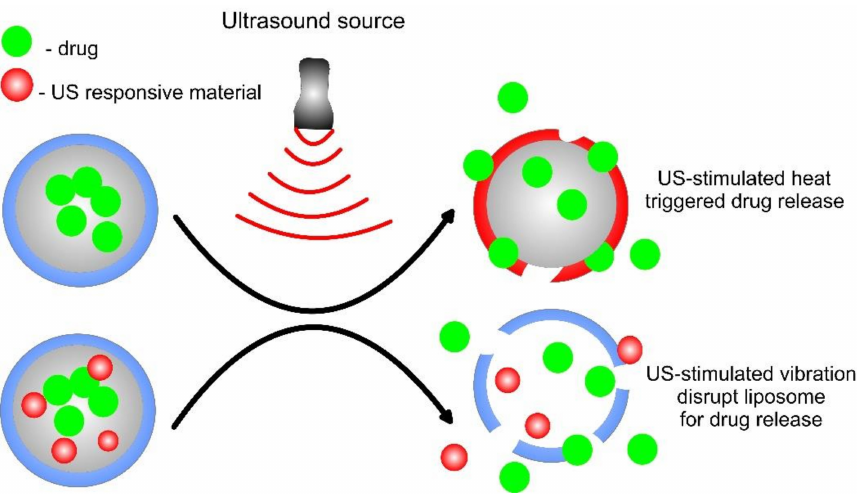
Figure 10. Ultrasound (US) triggered mechanisms of drug releases from